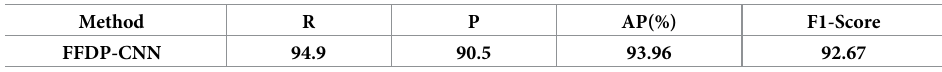
Table 11. F1-Measure on VEDAI.